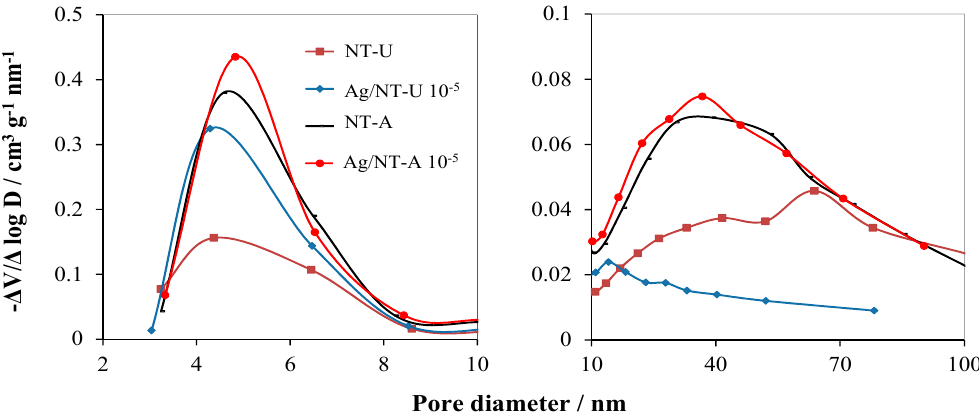
Figure 6. BJH pore-size distribution of the catalysts prepared.